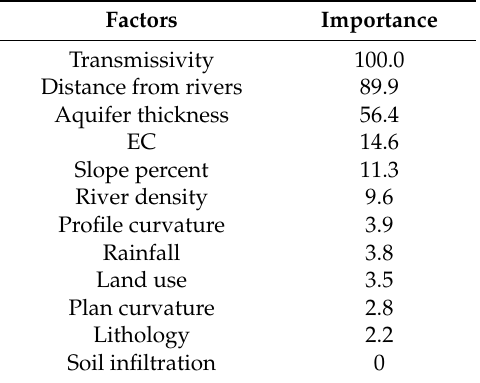
Table 2. The importance of the FWS conditioning factors in the BRT algorithm.